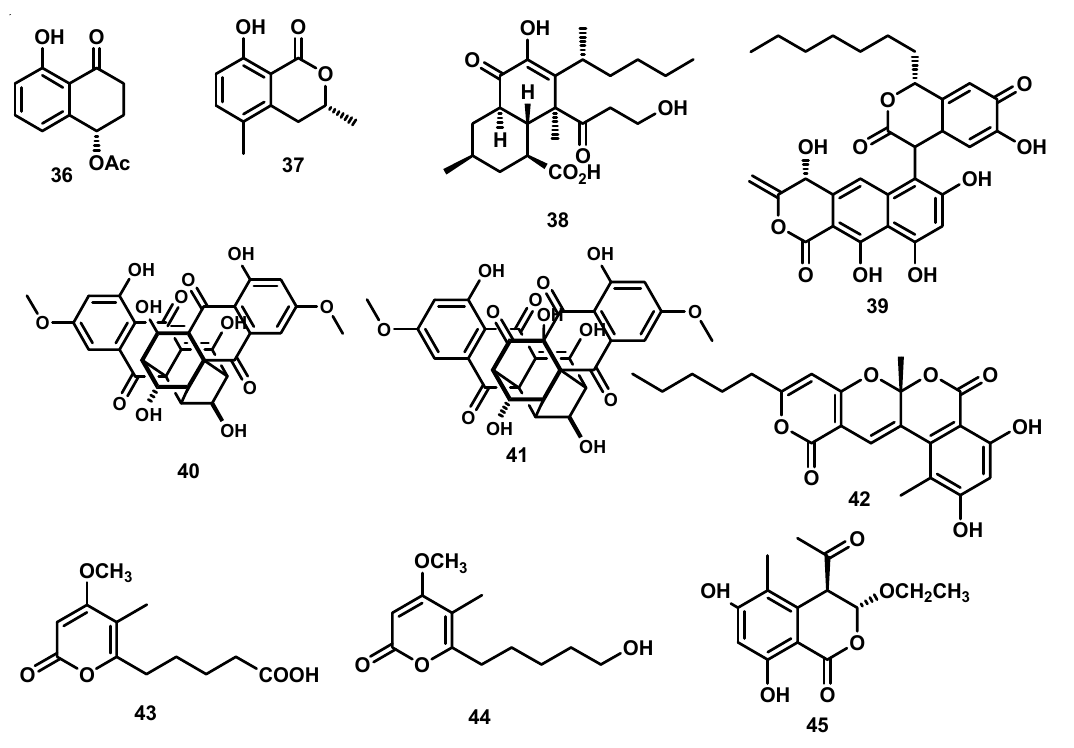
Figure 4. Dihydroisocoumarin, pyranone, bisanthraquinone, pyrone, and isocoumarin derivatives from the genus Cytospora .